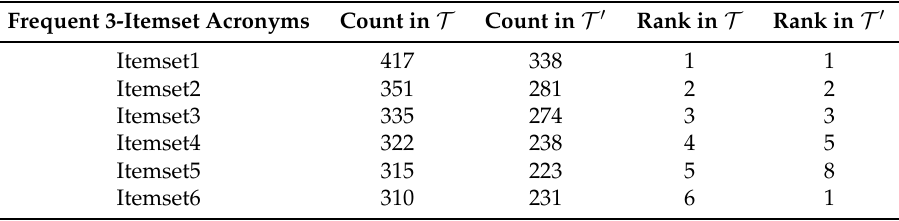
Table 6. Frequent three-itemsets (minimum support = 0.005).